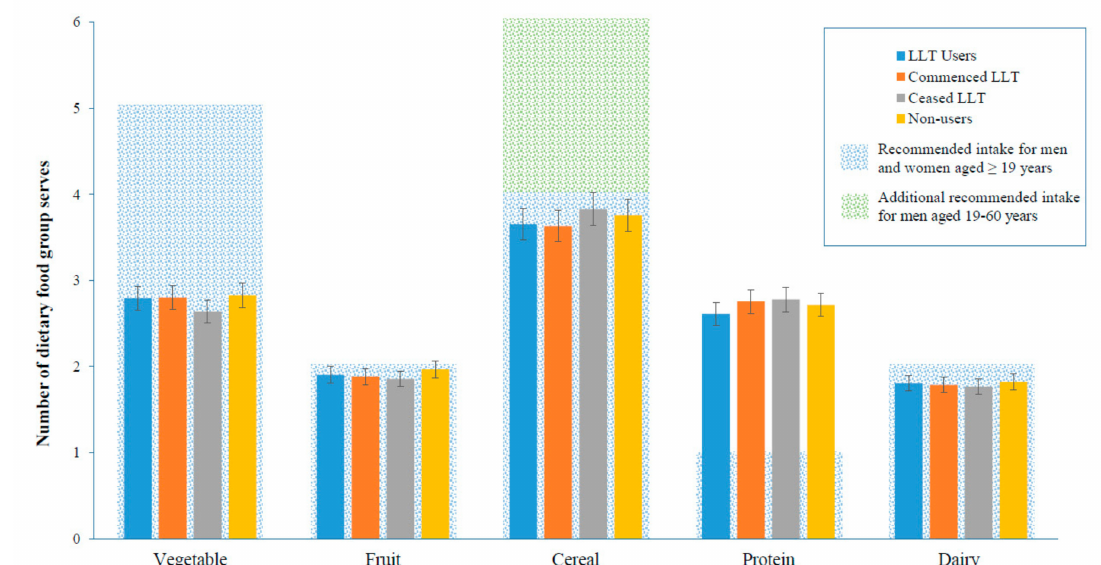
Figure 3. Adjusted total serves per day at the follow up of key food groups at the 75th quantile, by LLT (Lipid-lowering therapy) status, median (95% CI). Adjusted for age, gender, body mass index (kg / m 2 ), smoking status, exercise status, education status, diabetes status, prior cardiovascular disease, hypertension, and baseline dietary serves per